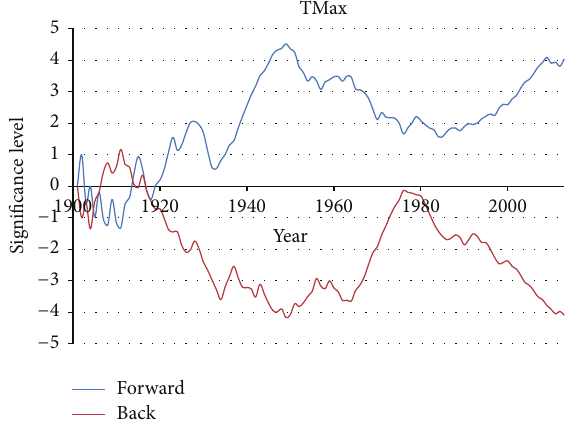
Figure 5: Change point detection of TMax during 1901–2013.